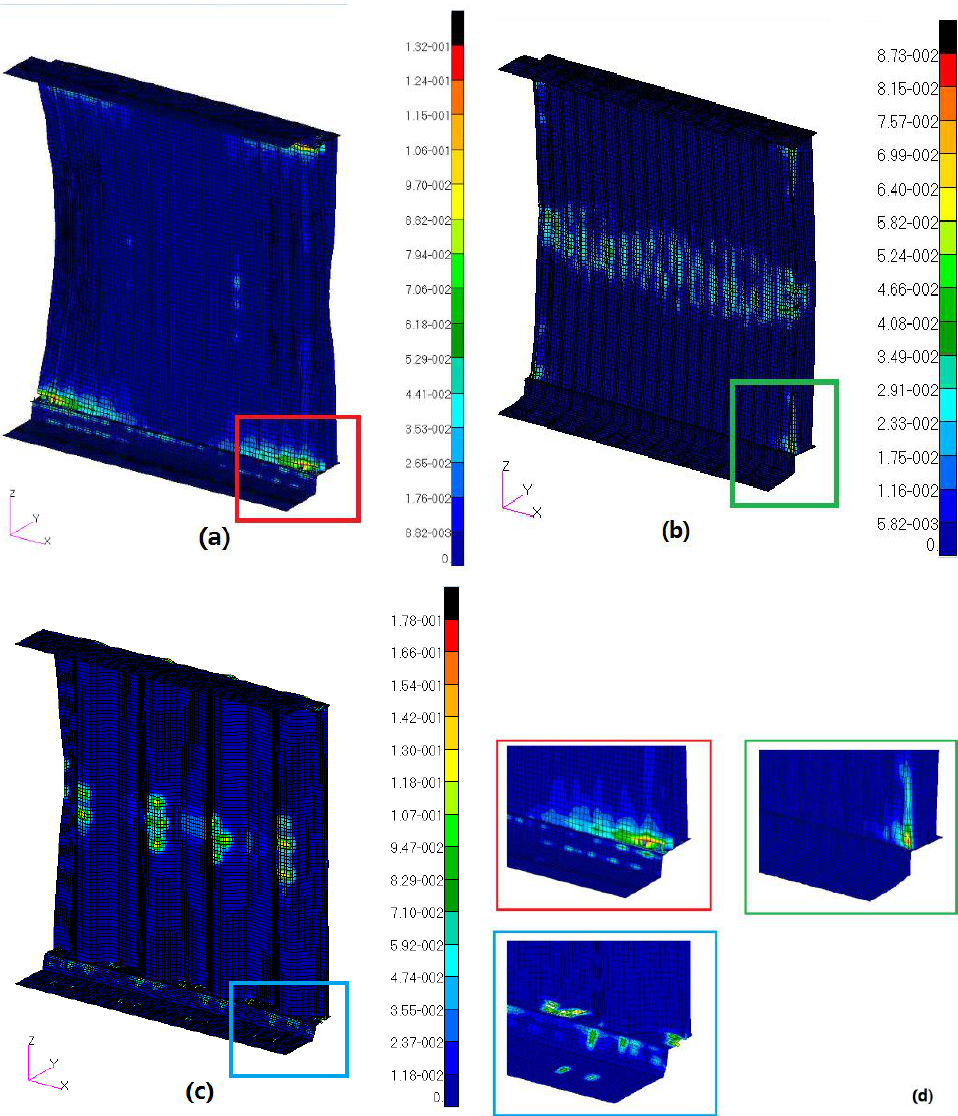
Figure 16. Permanent strain distribution of the blast walls: ( a ) ARBW; ( b ) HSBW; ( c ) CBW; ( d ) corner of blast wall.